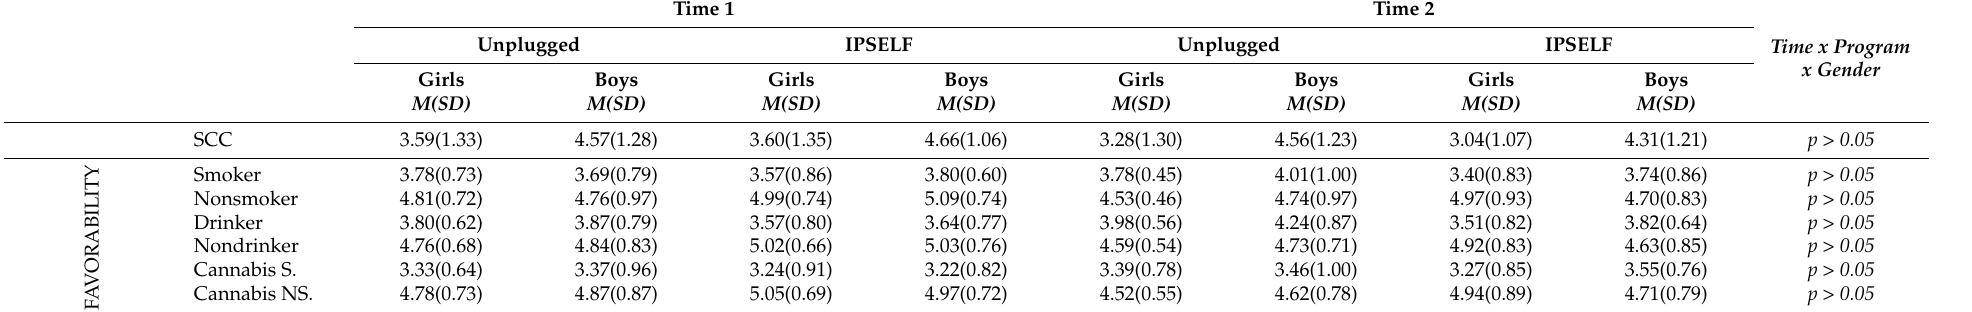
Table 2. Means at different scales by interaction between program and